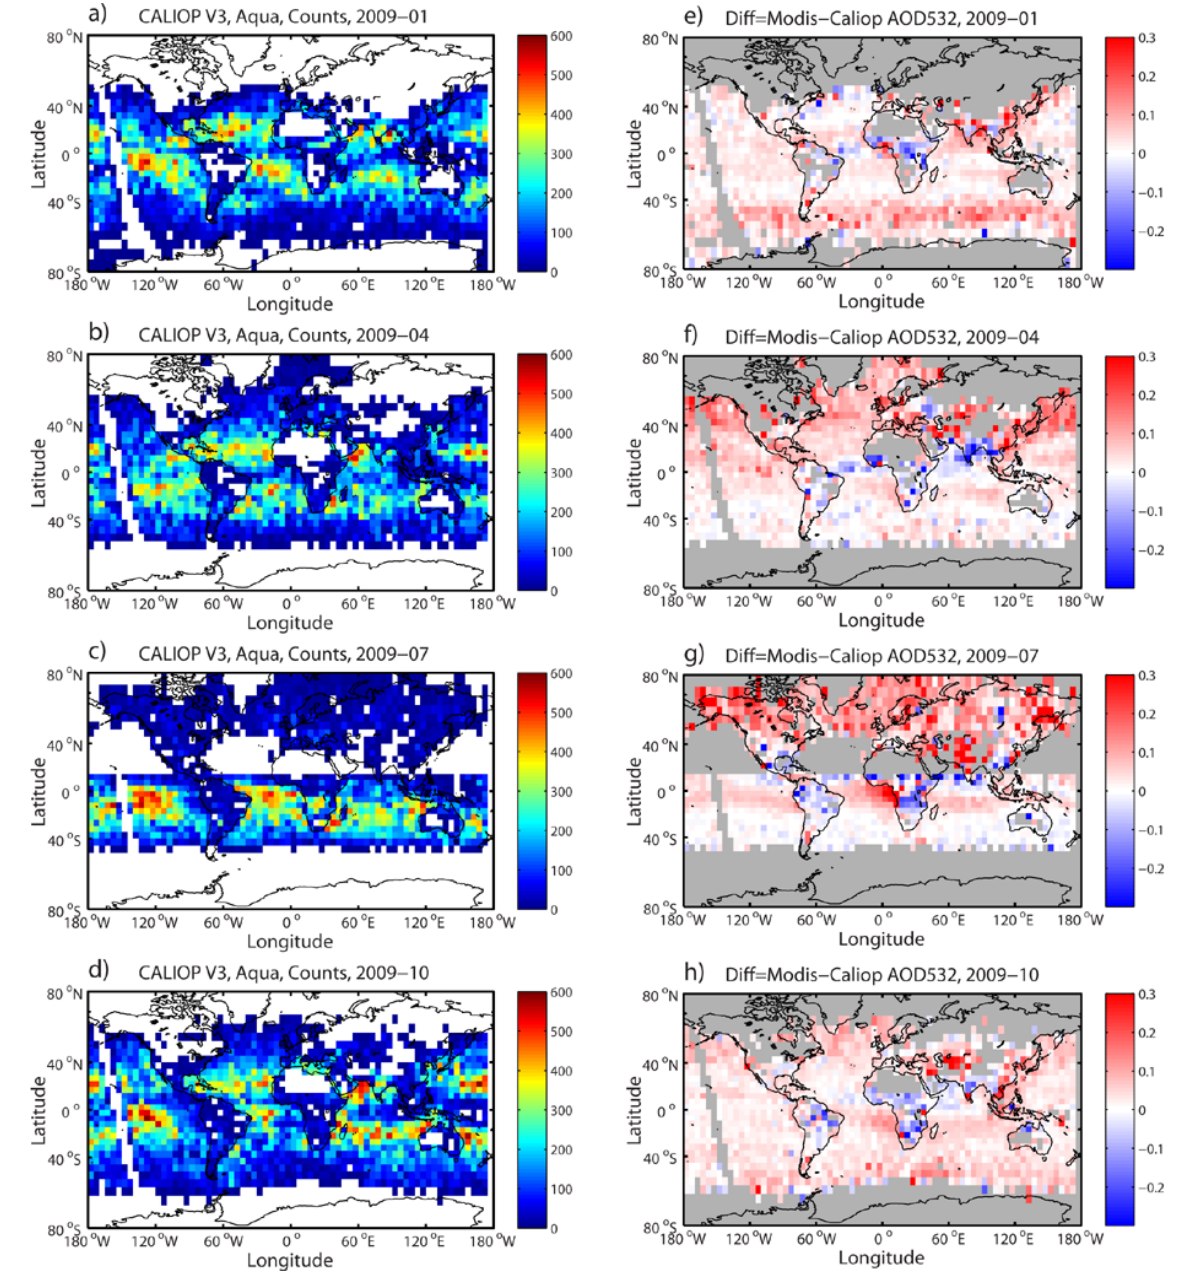
Fig. 9. Same as Fig. 8, but for data collected in